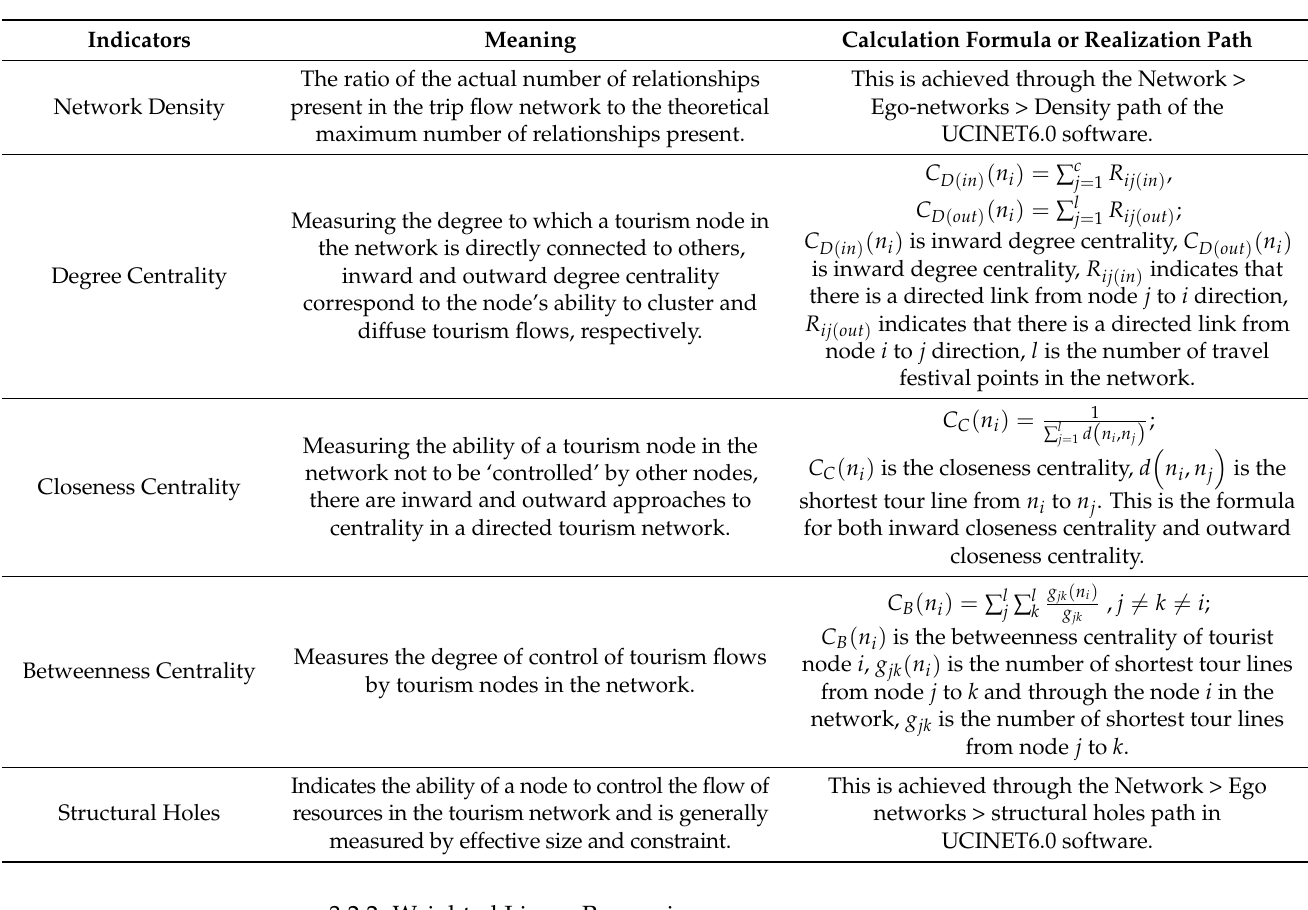
Table 1. Indicators of the structure of the tourism flow network and their meaning